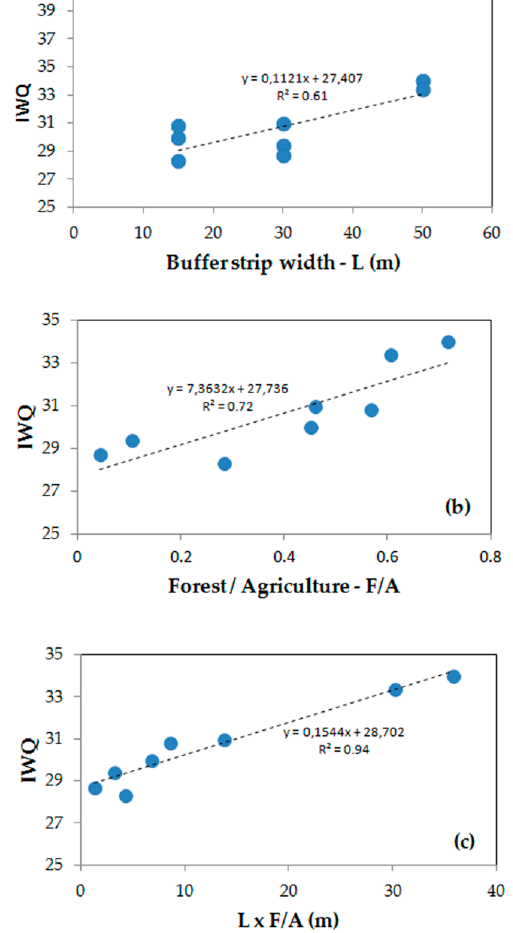
Figure 6. IWQ scatter plots. ( a ) This variable is projected as a function of buffer strip width (L), ( b , c ) as a function of ratio forest over agriculture (F/A) and interaction term L × F/A, respectively. The data used to draw the plots are depicted in Table 1 (L, F/A and L × F/A) and 3 (IWQ). Table 4. Results of multiple regression model. In this run, the IWQ was used as a dependent variable. Term β StdError ( β )